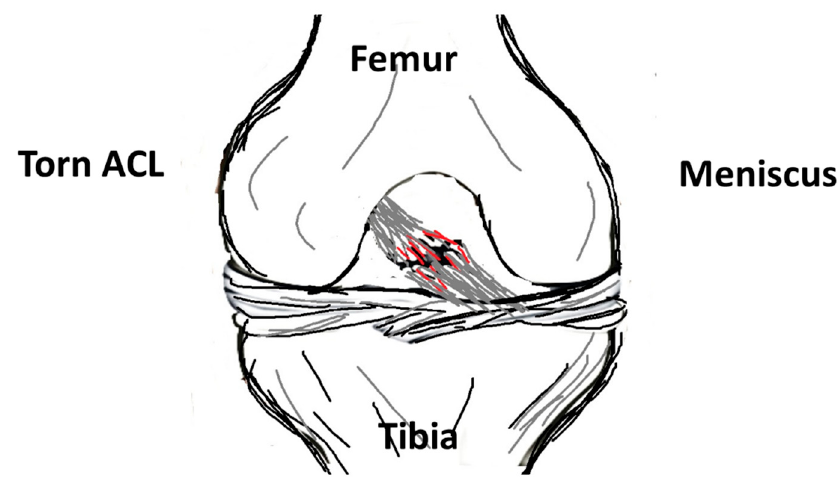
Figure 1. Schematic of a torn/ruptured anterior cruciate ligament (ACL) tissue. Structurally, ACL is a poorly vascularized connective tissue composed mainly of elastin, glycoproteins, glycosaminoglycans, and aligned collagen fibers (mostly type I) surrounded by fibroblast cells. It connects the femur and tibia with a basic function of stabilizing the knee joint through resisting anterior tibial translation and rotational loads.